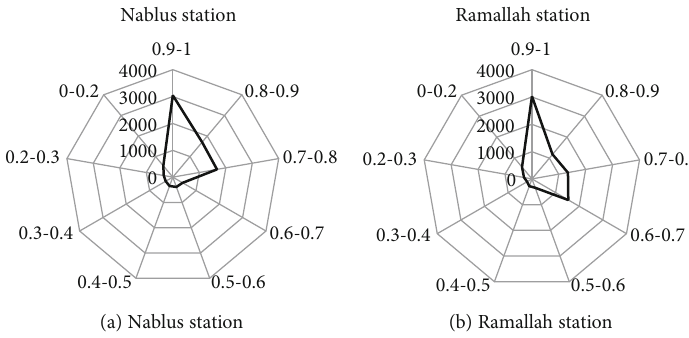
Figure 16: Usage of battery in Nablus and Ramallah stations for the second